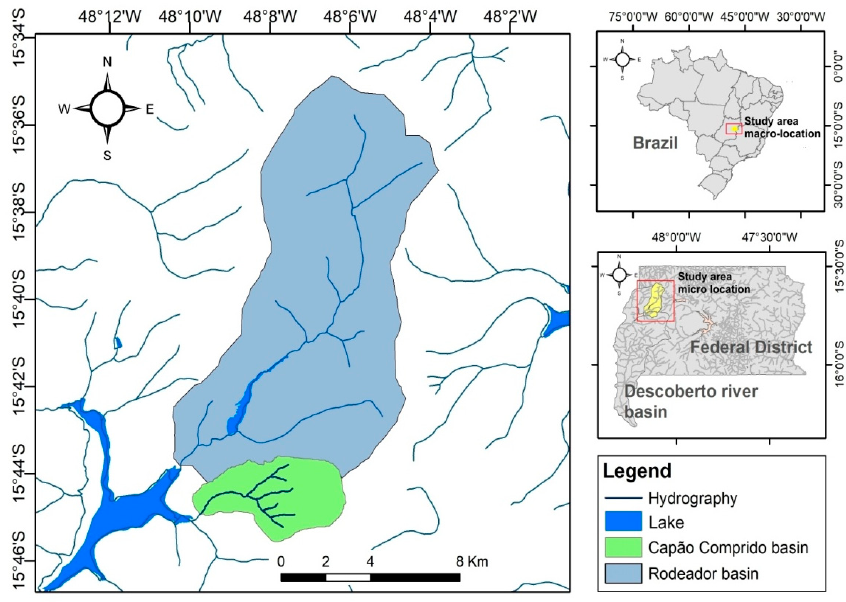
Figure 1. Location of the study area and the validation area.